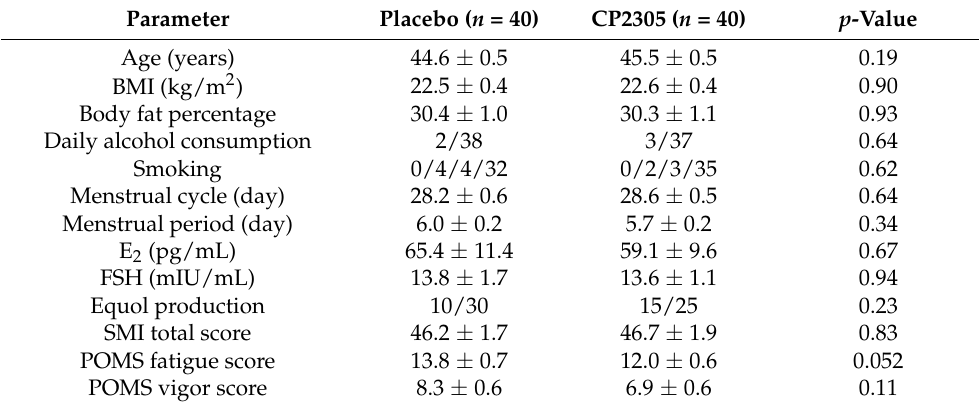
Table 2. Participant